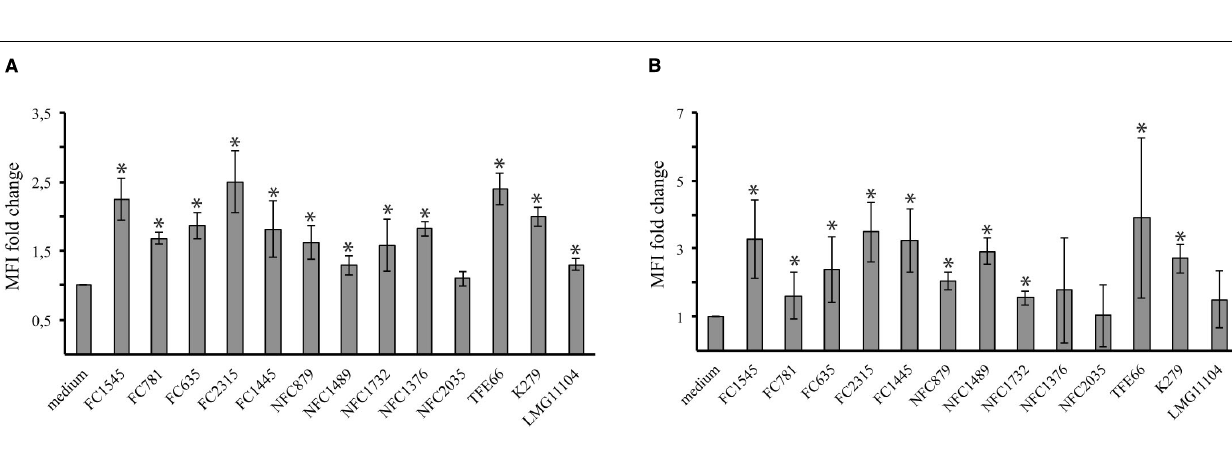
The mean fluorescence intensity (MFI) reflects the upregulation of molecule on cell surface. Each bar indicates the mean (cid:6) standard deviation of three independent experiments. * p < 0.05. Medium: iDCs uninfected.